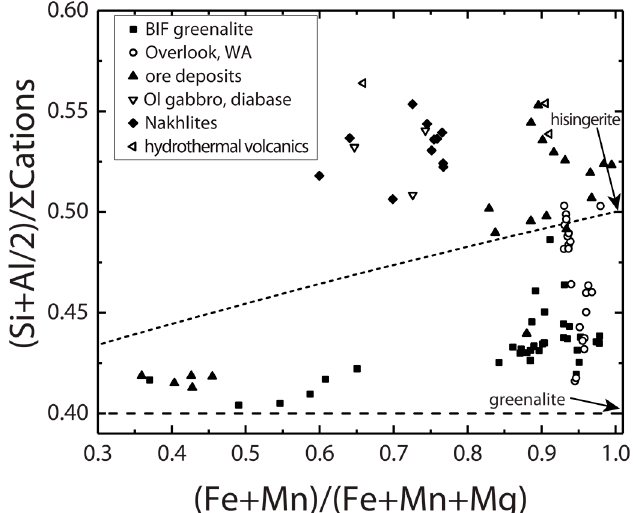
Figure 4. Electron microprobe (EMP) spot analyses of Martian nakhlite meteorite hisingerite, and Overlook greenalite (this work), as well as numerous literature analyses of greenalite and hisingerite in diverse geological environments [6,24,40–43,45,47,49–65]. Al/2 is included in the Si count because, unlike in peridotites, Al 2 O 3 in many of the literature samples is greater than 1.0 wt.%.